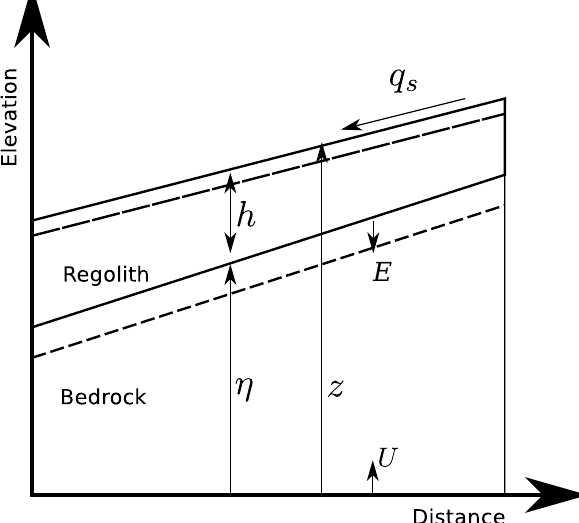
Figure 1. Diagram showing the conservation of mass within a 2-D domain where mass enters the system through uplift, U (units of ms − 1 ), and exists as sediment transported, q s (m 2 s − 1 ), out of the domain. E (ms − 1 ) is the rate of production of regolith, h (m) is the thickness of regolith, η (m) is the bedrock elevation, and z (m) is the total